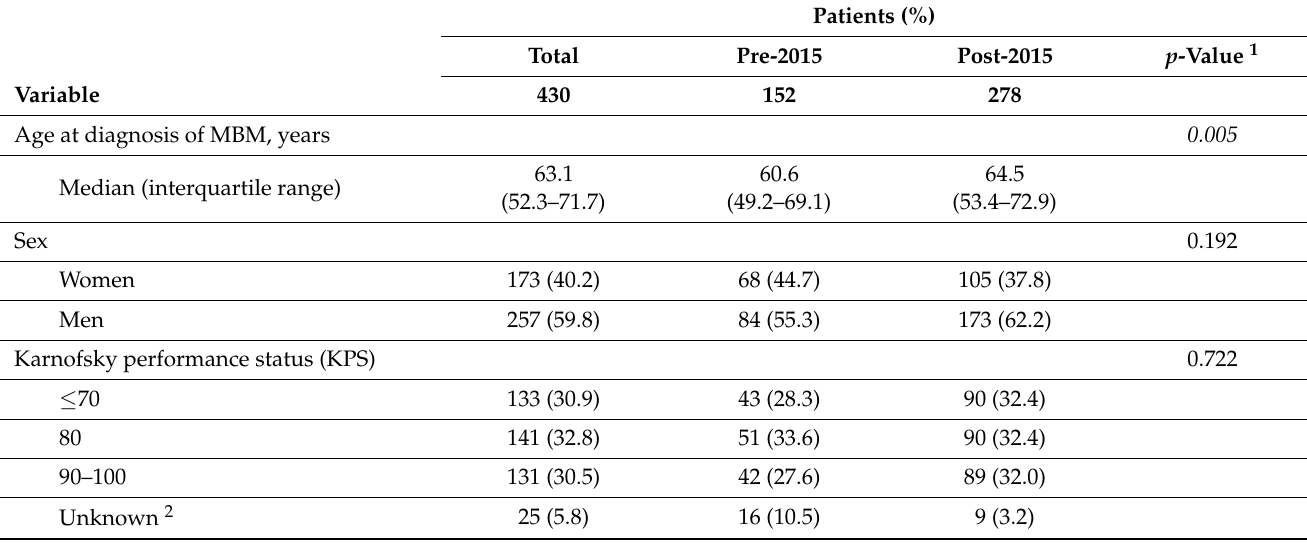
Table 1. Baseline characteristics of patients at diagnosis of melanoma brain metastasis